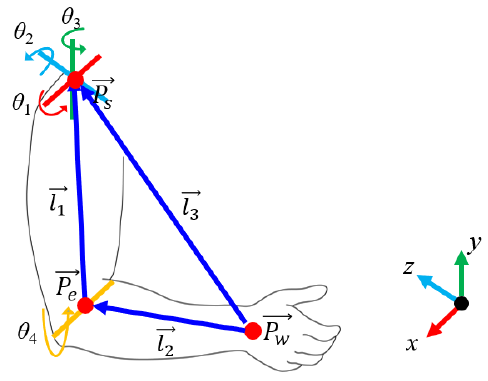
Figure 2. The human arm model.